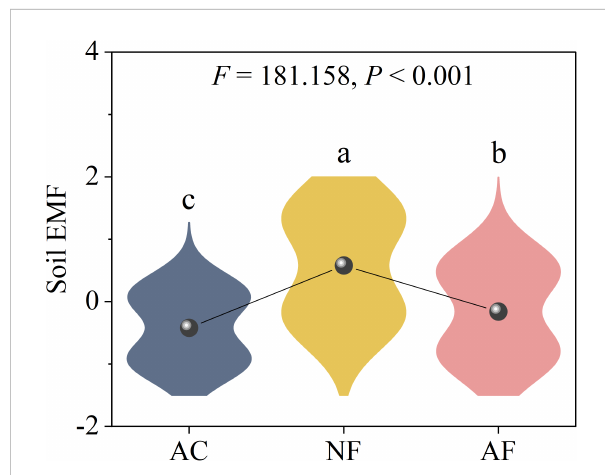
FIGURE 3 Effect of vegetation restoration on soil ecosystem multifunctionality in abandoned cropland. AC, abandoned cropland; NF, naturally restored secondary forest; AF, arti fi cial planted forest. Different